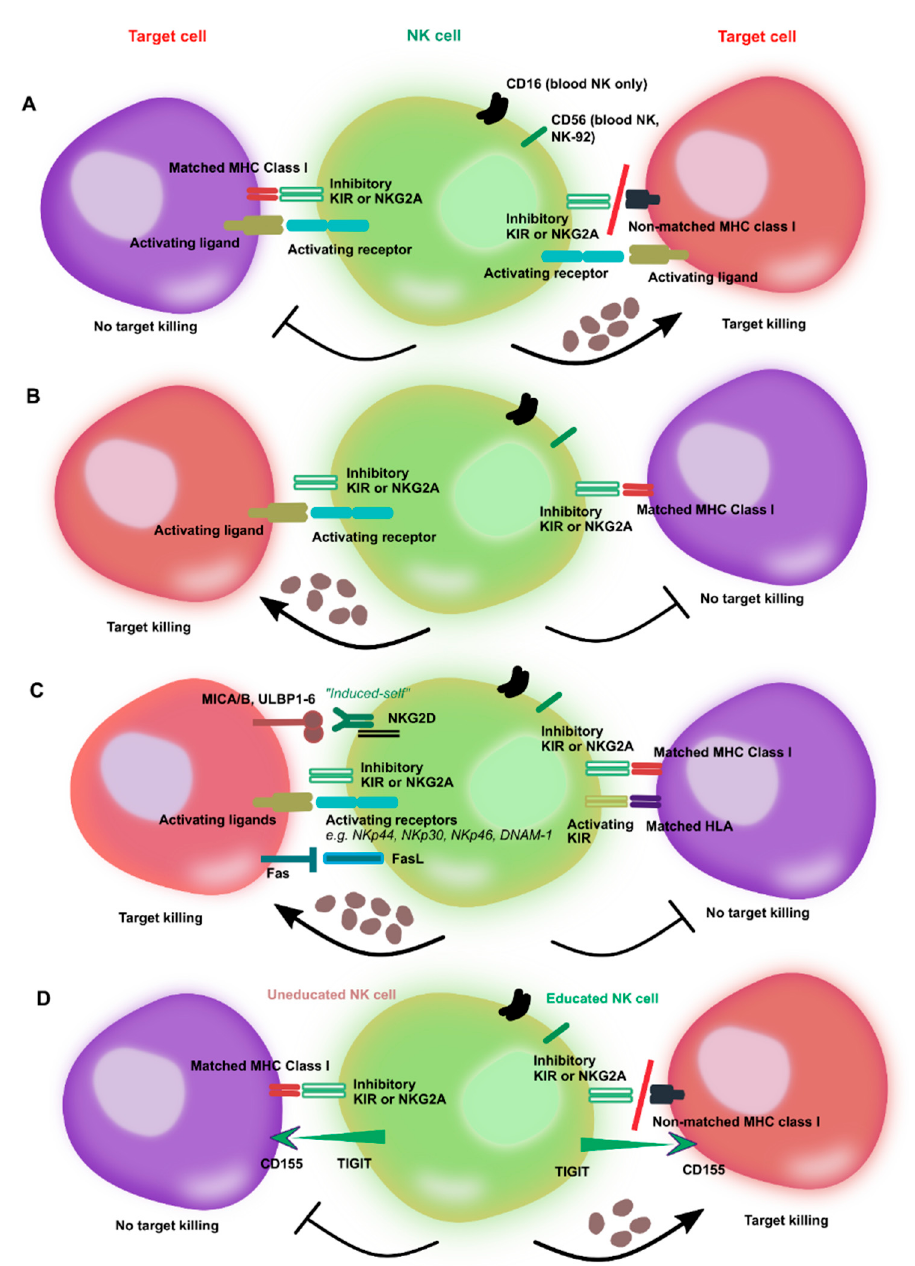
Figure 1. Activation of natural killer (NK) cells by inhibitory and activating receptors and modes of killing of target cells. ( A ) Recognition by inhibitory killer immunoglobulin-like receptors (KIRs) of major histocompatibility complex (MHC) class I molecules on cancer cells inhibits NK cell killing due to “missing self” recognition despite the presence of activating receptors. The balance between inhibitory and activating signals does not induce NK cell activation. However, NK cells are triggered to kill their targets when no matching KIR ligand is present, which shifts the balance toward NK cell activation. ( B ) The lack of MHC molecules prevents inhibition of NK cytotoxicity and promotes NK-induced killing of targets by activating receptor engagement. However, MHC ligand mismatch is not by itself sufficient to trigger NK cell killing in absence of signals from activating receptors. ( C ) Many cancer cells dowregulate the expression of MHC ligands. Even with the lack of MHC ligand expression, the balance of activating receptors in favor of killing signals can trigger NK-mediated lysis of cancer targets. Activation is further promoted by the recognition of stress ligands on cancer cells, as well as “induced self” ligands, such as MICA/B and ULPB1-6 for NKG2D. Conversely, a balance